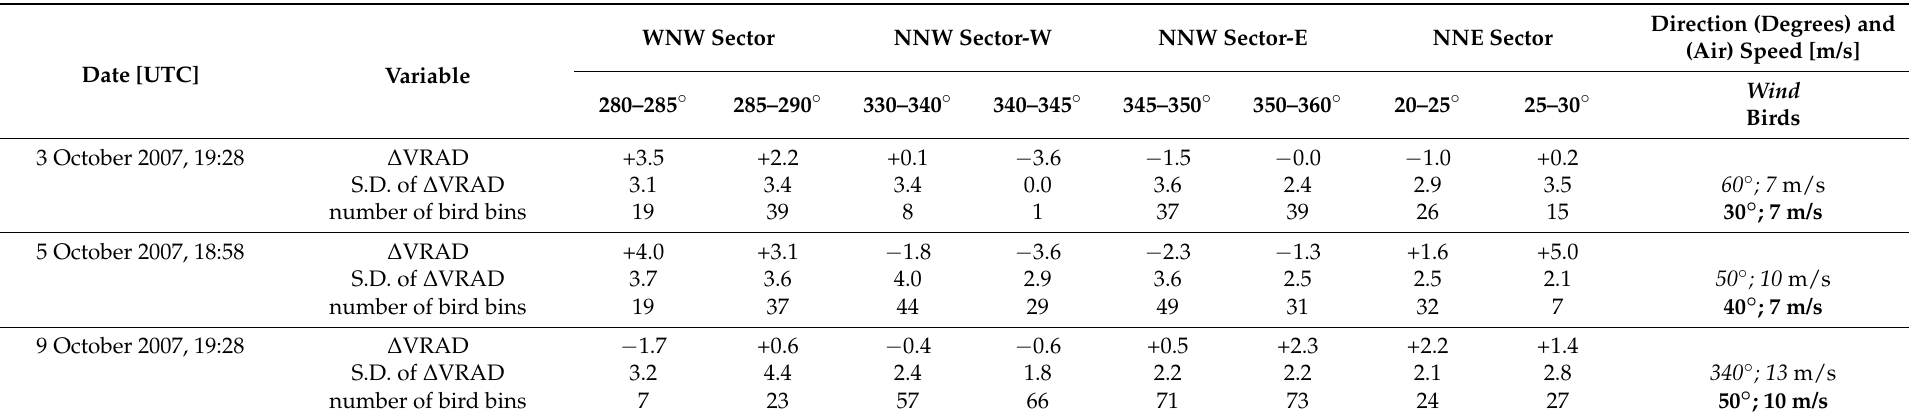
Table 1. Residual radial velocity ∆ VRAD in bird migration cases 3, 5, and 9 October 2007. ∆ VRAD, its standard deviation, and the number of bird bins in 5 degrees azimuth sections, at a range of 40 to 43 km. Number of bird bins denotes the number of bird bins in an area of approximately 10 km 2 , in an altitude range of 100–700 m. The column direction and speed shows wind and bird migration directions (as directions from which they originate). Radial velocity is negative for movements towards the radar. The minus signs denote the measured radial velocity being more negative than the expected value, and plus signs denote the radial velocity being more